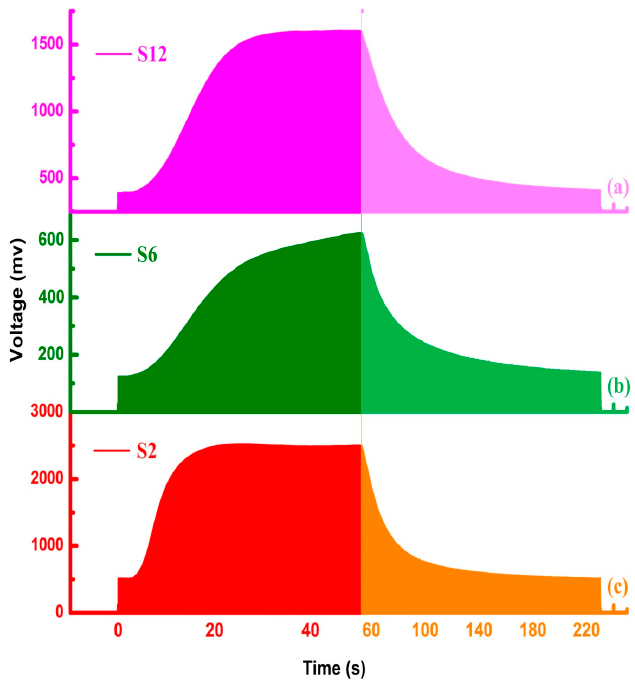
Figure 3. The areas under the response signals obtained by S12 ( a ) S6 ( b ) and S2 ( c ) from the wine samples of